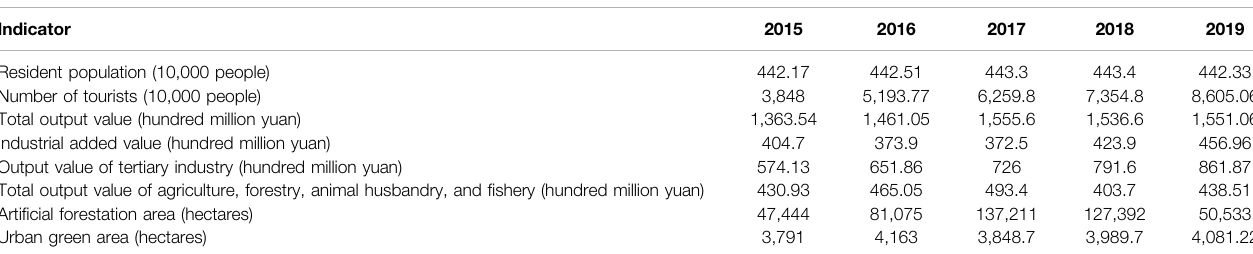
TABLE 4 | Socioeconomic data of Zhangjiakou City.